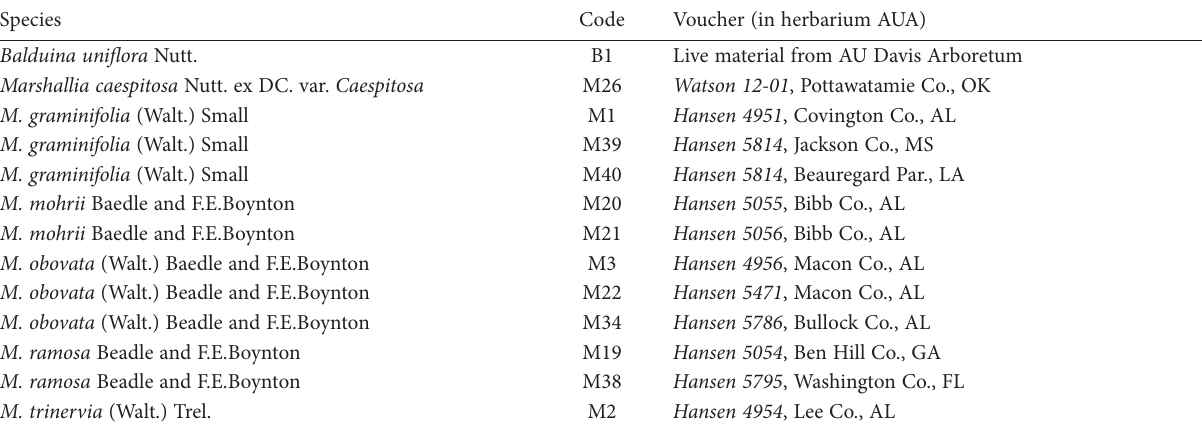
Table 1. Marshallia and Balduina species studied including population code and origin.